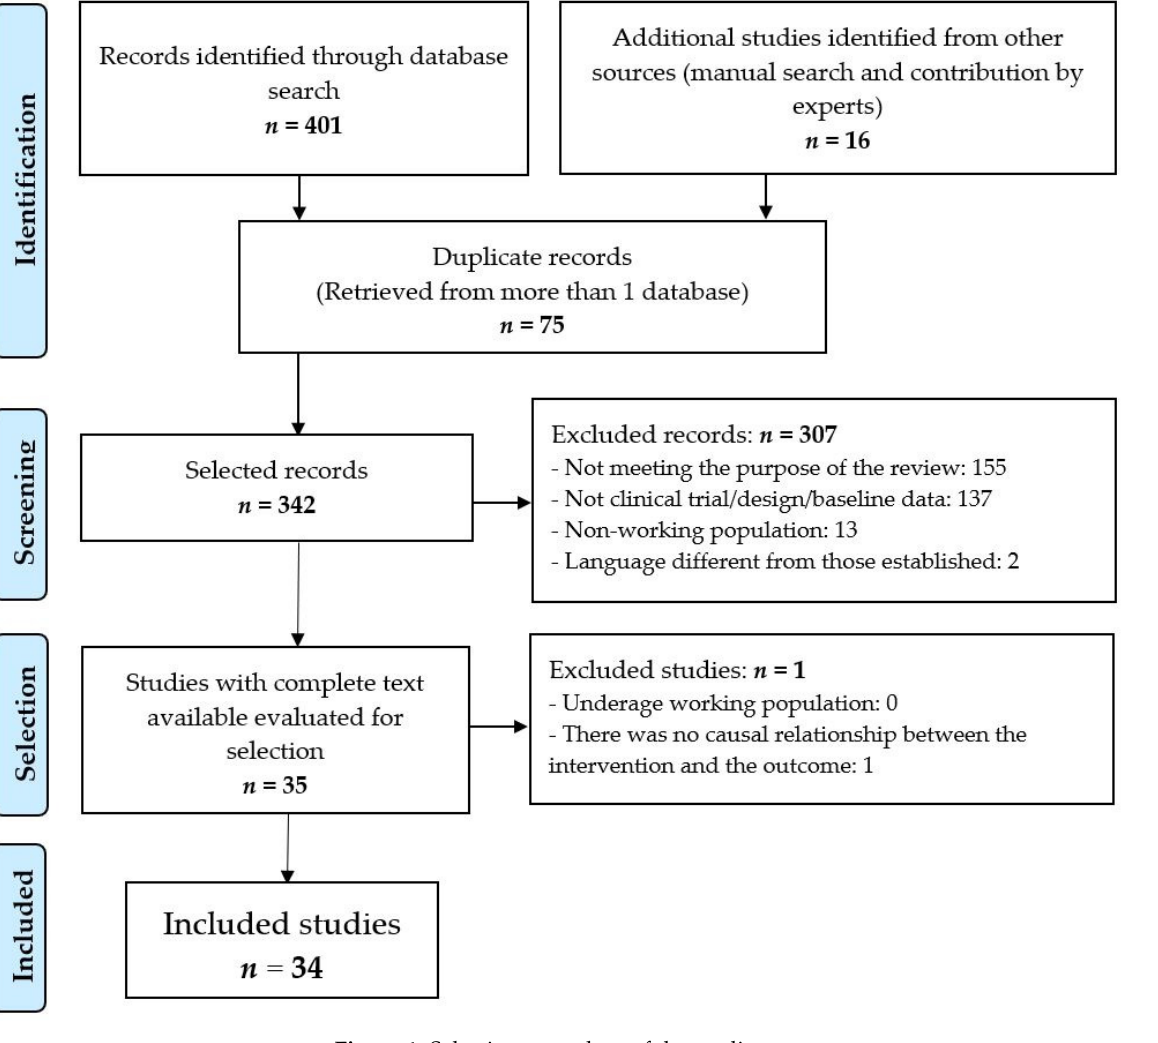
Figure 1. Selection procedure of the studies. Table 1. Summary of the studies reviewed.